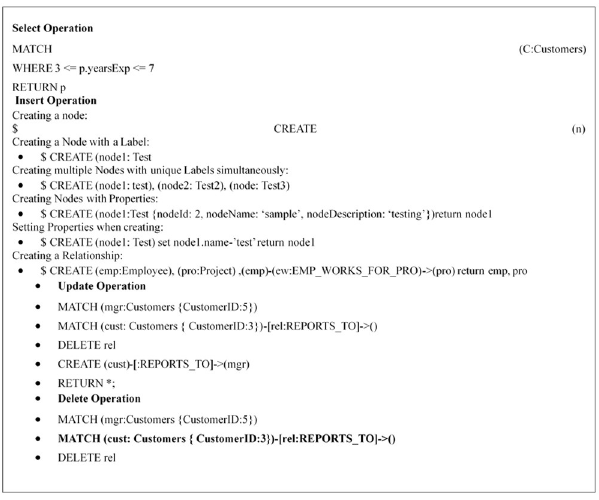
Fig 6. Noe4j libraries.